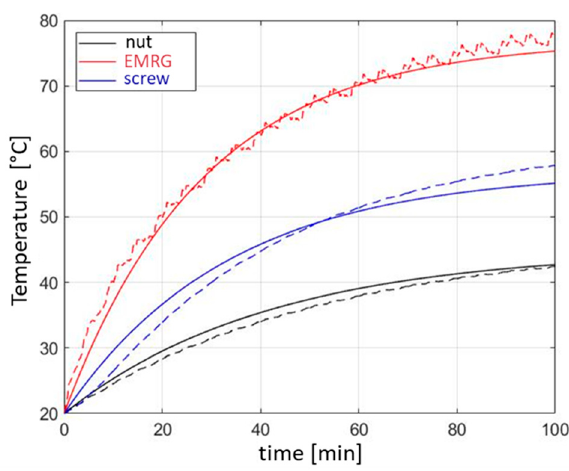
Figure 16. Thermal profiles: EMRG (red), nut (black), and screw (blue).